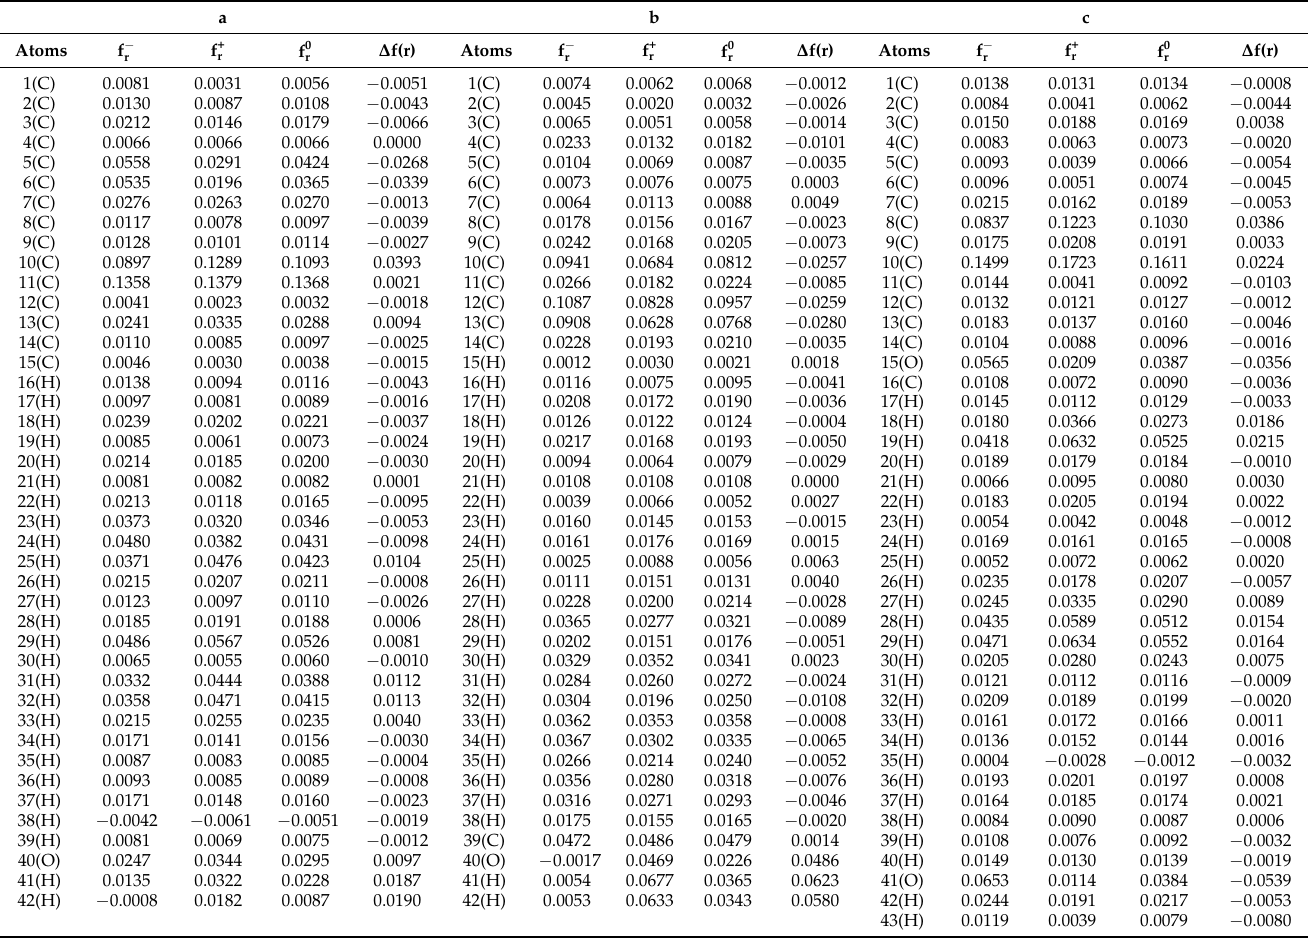
Table 3. The condensed Fukui functions for the binary mixtures α -cubebene–water (a), β - caryophyllene–water (b), and caryophyllene oxide–water (c).